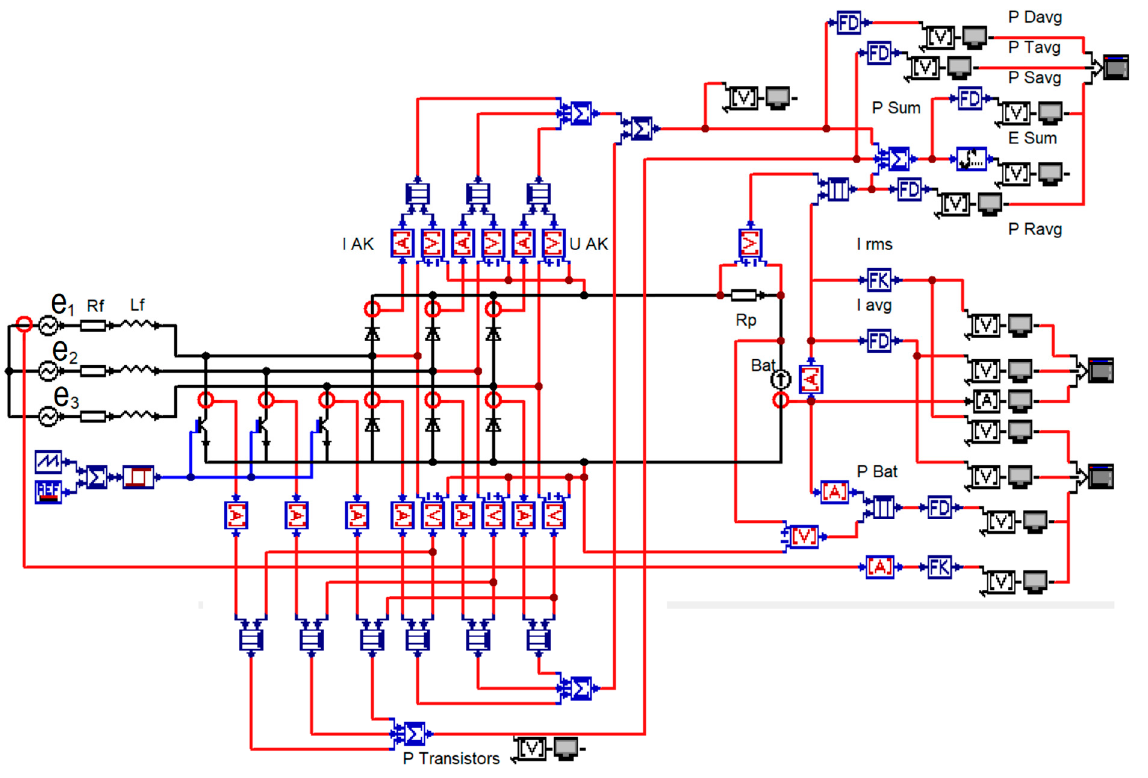
Figure 6. Simulation circuit of the three-switch converter.